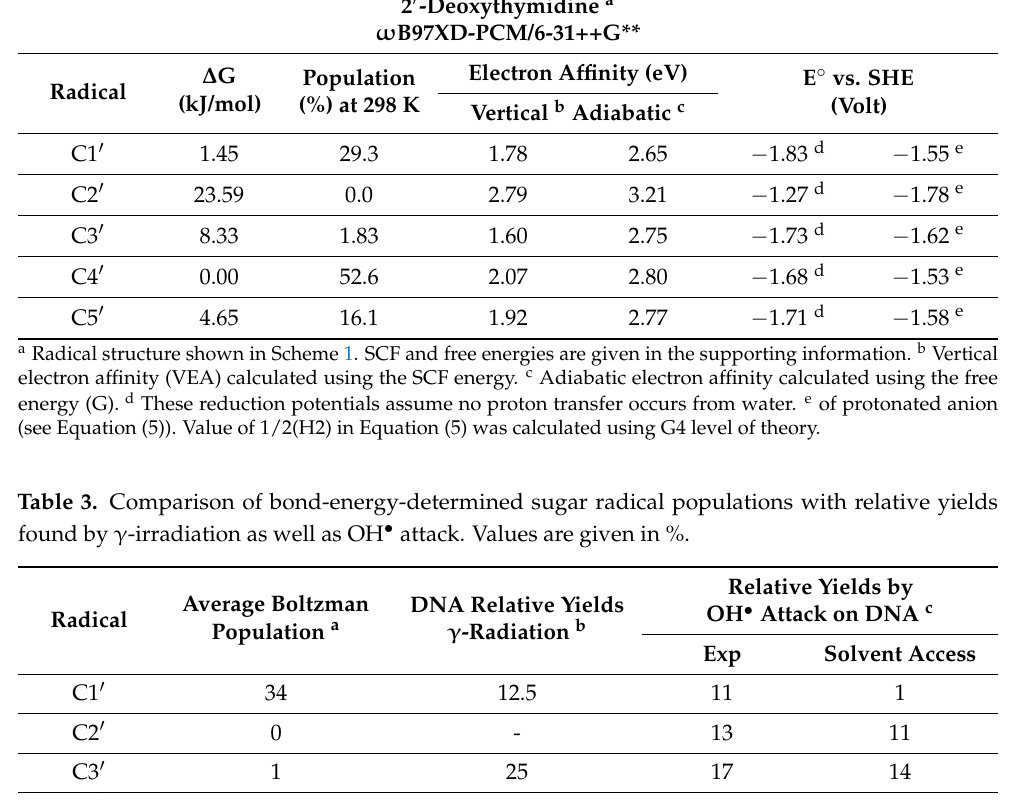
The normalized values are given. See reference [17]. c See reference